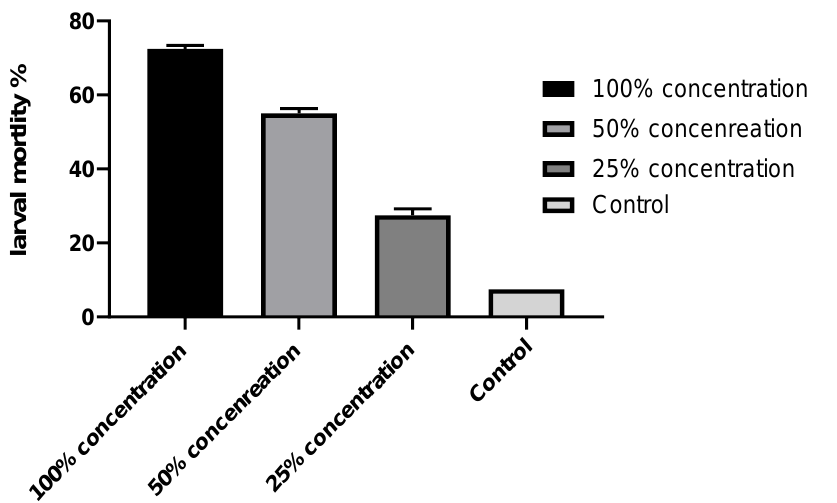
Figure 3. Percentage of mortality in Spodoptera littoralis larvae fed on leaves treated with the SCG extract.